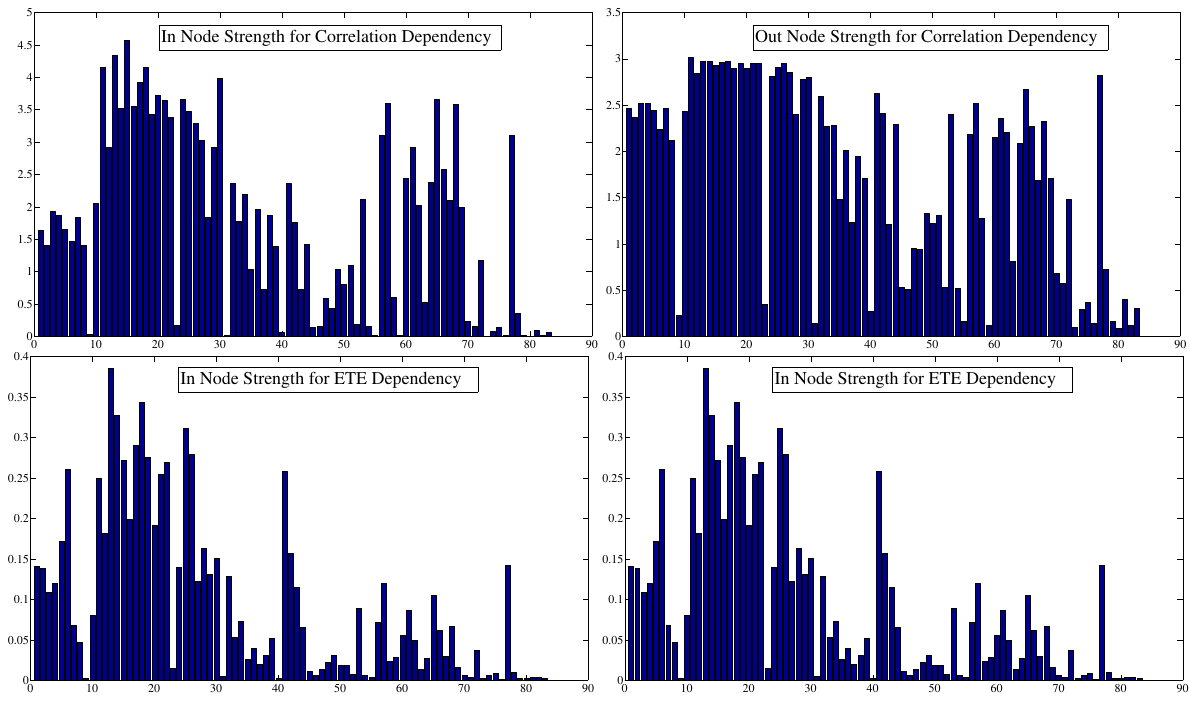
Figure 15. Node Strengths for Correlation ETE